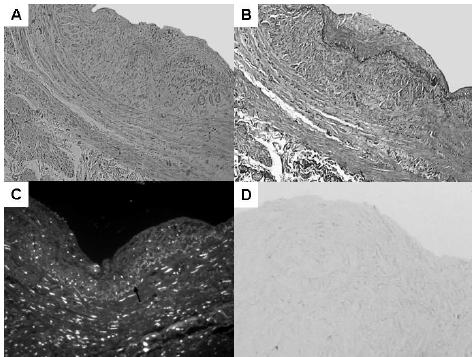
Figure 2 - Morphological and integrity analyses of fresh excised human saphenous vein. HE stain (A) and VVG stain (B) demonstrating the tissue structure. Hoechst 33258-labeled cell nuclei (C) and TUNEL assay (D) showing tissue cellular density with no presence of apoptotic processes.